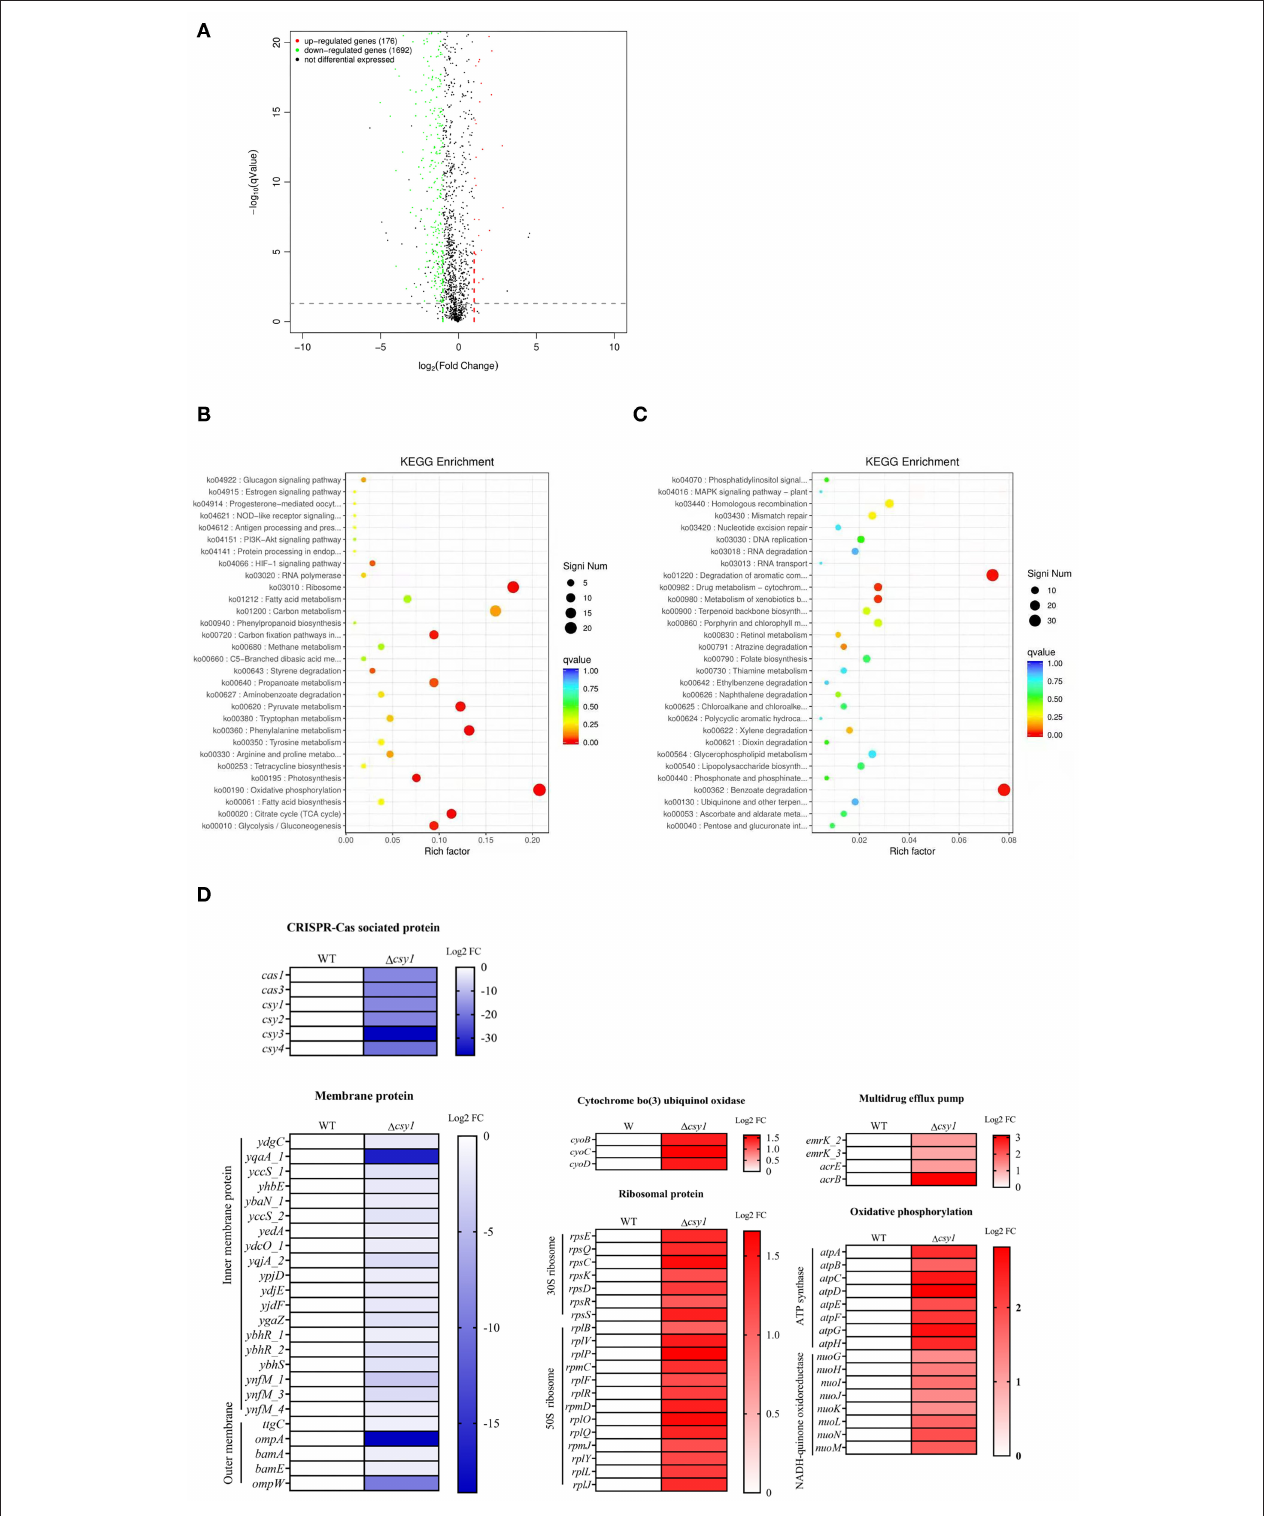
FIGURE 5 | Transcriptome analysis of AB43 and AB43 1 csy1 . (A) Differential gene volcano map; (B) Kyoto Encyclopedia of Genes and Genomes (KEGG) enrichment analysis of up-regulation genes; (C) KEGG enrichment analysis of down-regulation genes; the color of the dot represents the size of the Q-value, and the size of the dot represents the number of differential genes; (D) Selected differential expression genes involved in CRISPR-Cas related protein, ribosome protein, oxidative phosphorylation related protein, a membrane-associated related protein, and multidrug efflux pump protein.